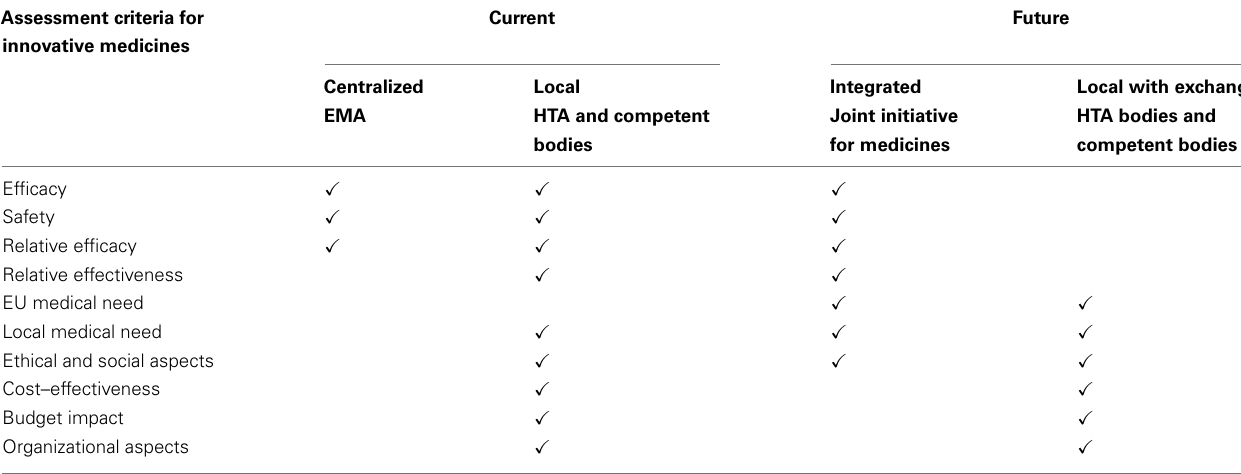
Table 1 |Assessment of innovative medicines in the European Union. Assessment criteria